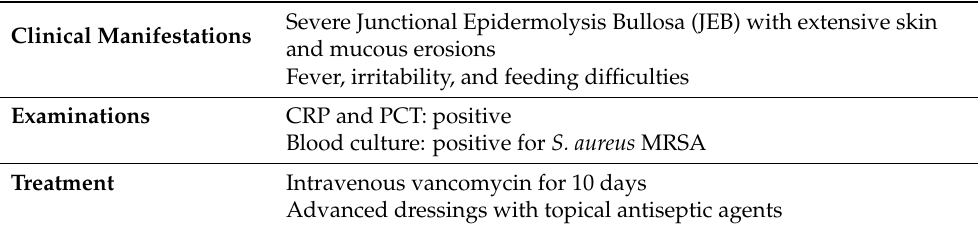
Table 5. Summary of case 3 with epidermolysis bullosa and Staphylococcal sepsis probably due to extended skin